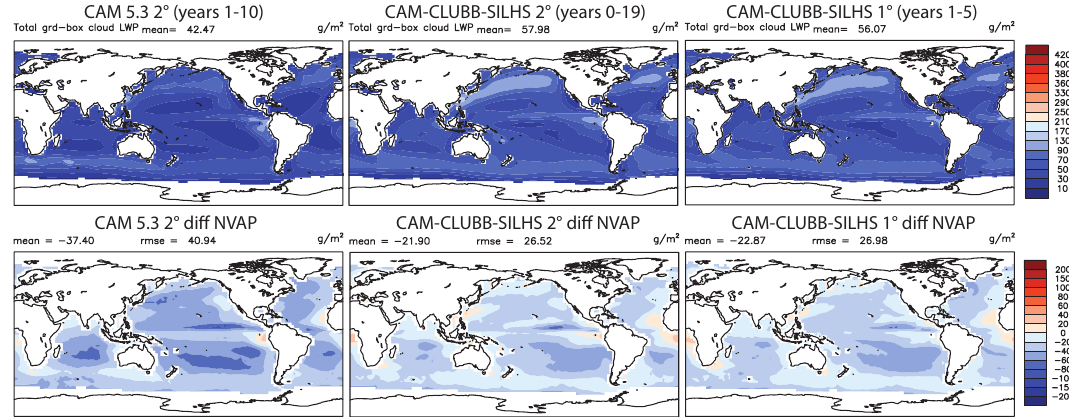
Figure 7. Total grid-box liquid water path (LWP) for CAM 5.3 (left), CAM-CLUBB–SILHS 2 ◦ (center), and CAM-CLUBB–SILHS 1 ◦ (right). The difference from NVAP observations of LWP is shown in the second row. The global mean LWP in CAM-CLUBB–SILHS is about 35% higher than that of CAM 5.3. Table 4. Globally averaged top-of-the-atmosphere (TOA) radiation fields, and the top-of-model (TOM) radiation imbalance for various configurations of CAM-CLUBB–SILHS. Estimates of observational uncertainty are from Stephens et al. (2012). Values are in units of Wm − 2 . Simulation Length Net Upward Long-wave Shortwave TOM solar long-wave cloud cloud imbalance flux flux forcing forcing Observations (CERES-EBAF) – 240.5 ±